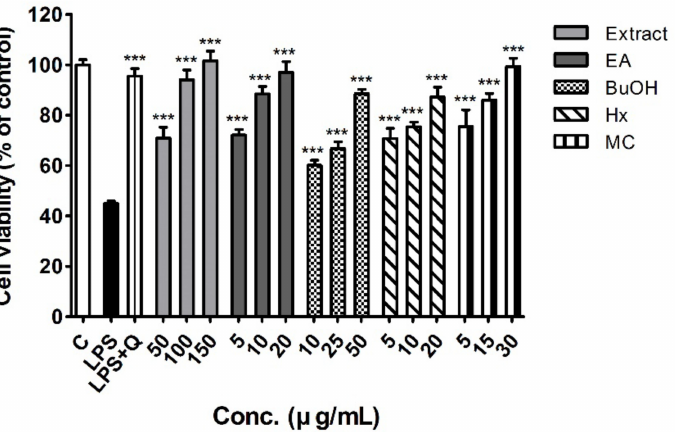
Figure 1. Effects of the EtOH extract and fractions of white mulberry fruits on cellular viability of RAW 264.7 macrophages stimulated with lipopolysaccharide (LPS, 2 µ g/mL). Data are expressed as means ± SD ( n = 5). *** p < 0.001 vs. LPS